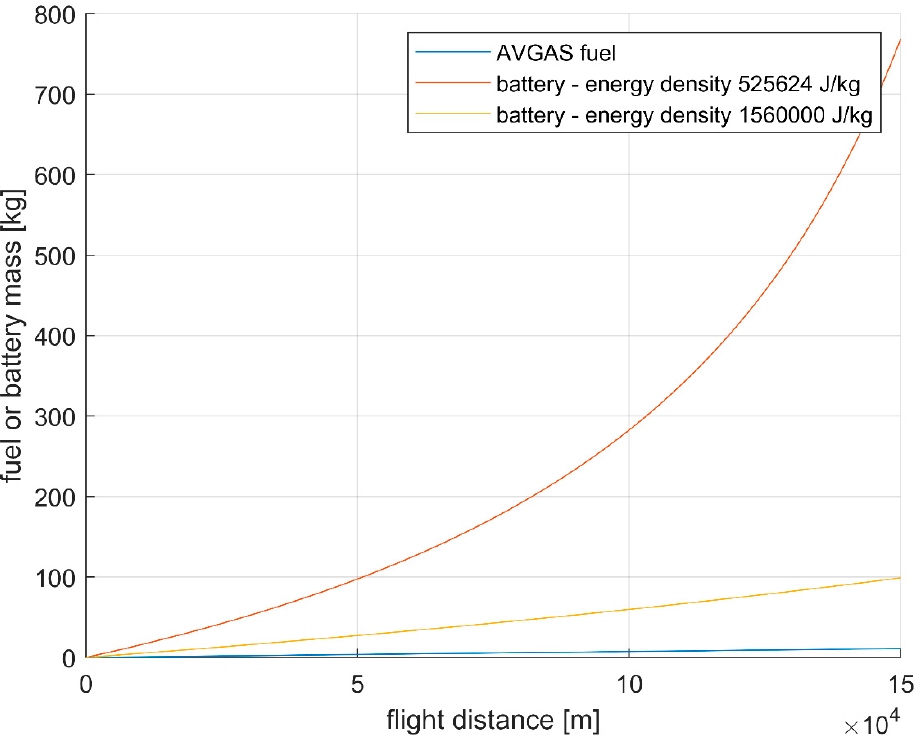
Figure 2. Flight distance for different energy density.